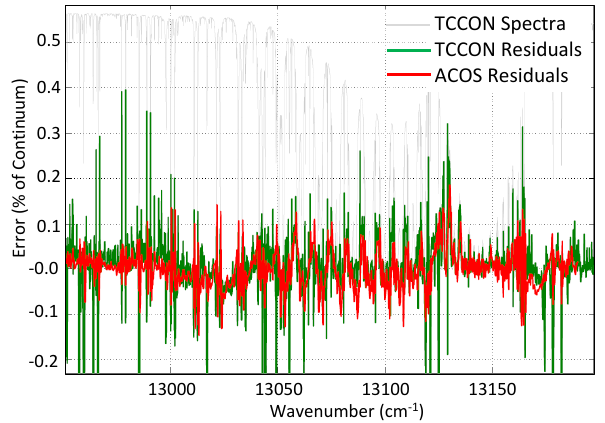
Fig. 6. Comparison of spectral residuals in the O 2 A-band from TCCON (green) and ACOS GOSAT (red) retrievals, along with a TCCON O 2 A-band spectrum (light